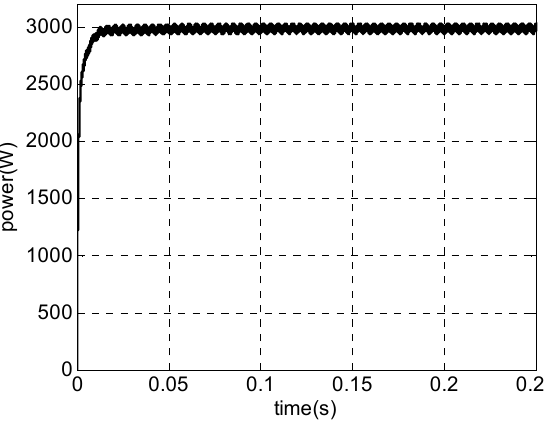
Figure 16. Simulations results for a PMSG. For v wind = 12 m/s (rated power): phase voltage and current.